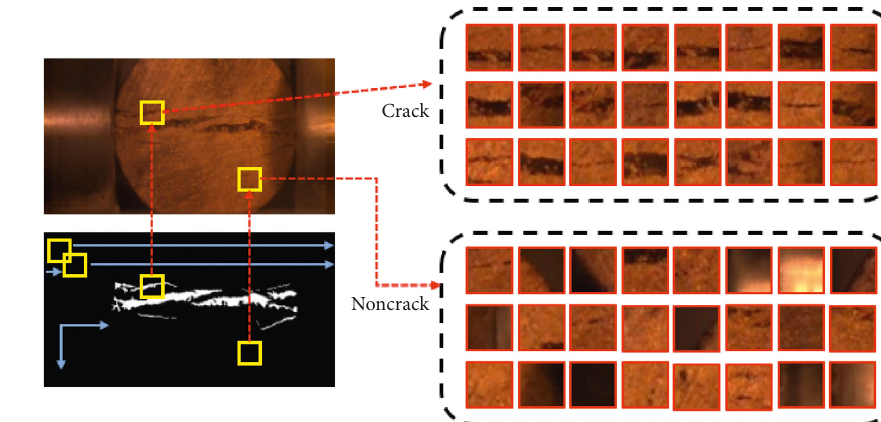
Figure 5: Dataset creation process.